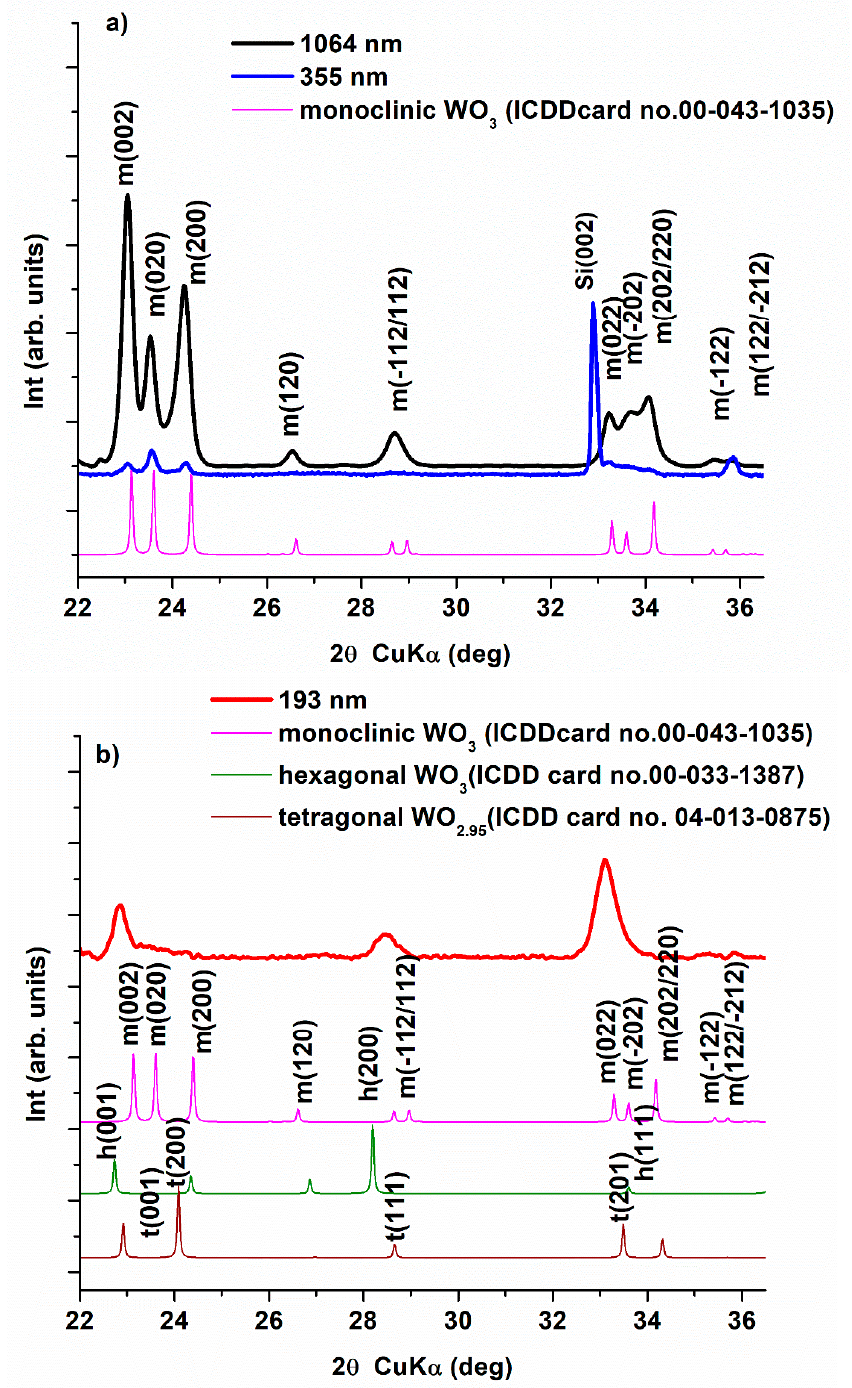
Figure 1. ( a ) XRD diffractograms of WO 3 thin films deposited onto PtSi substrate at different laser wavelengths: 1064 nm (black line) and 355 nm (blue line) and, ( b ) XRD diffractogram of the WO 3 film deposited at 193 nm (red line).